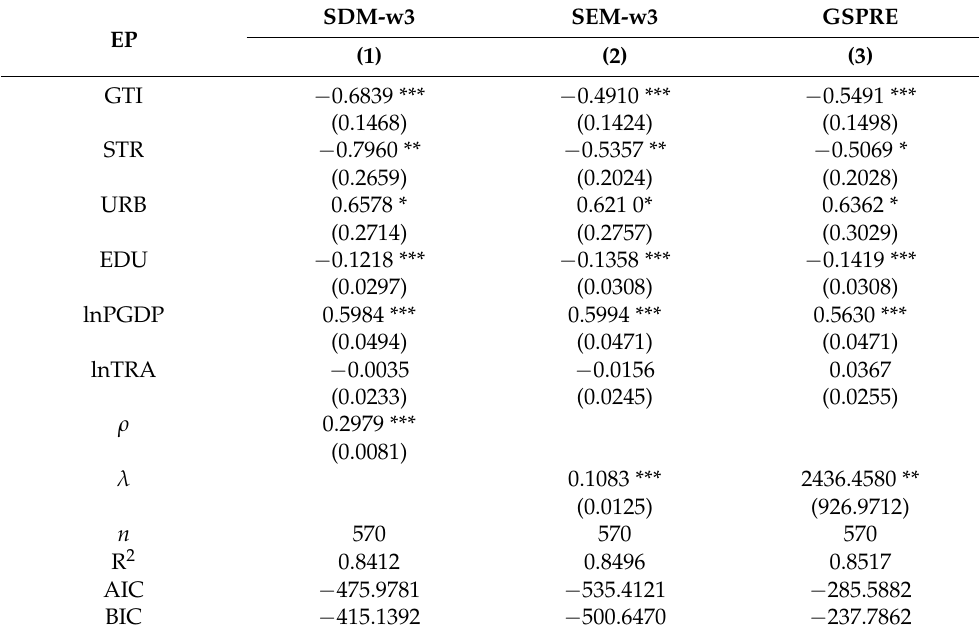
Table 8. Spatial panel regression results of GTI on CE